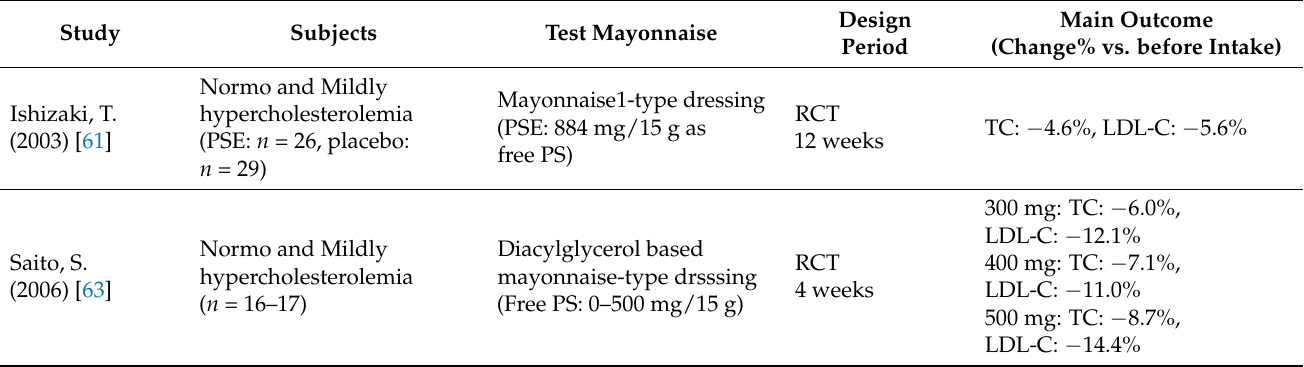
Table 3. Effects of plant sterol containing mayonnaise-type dressing on serum total and LDL- cholesterol levels in